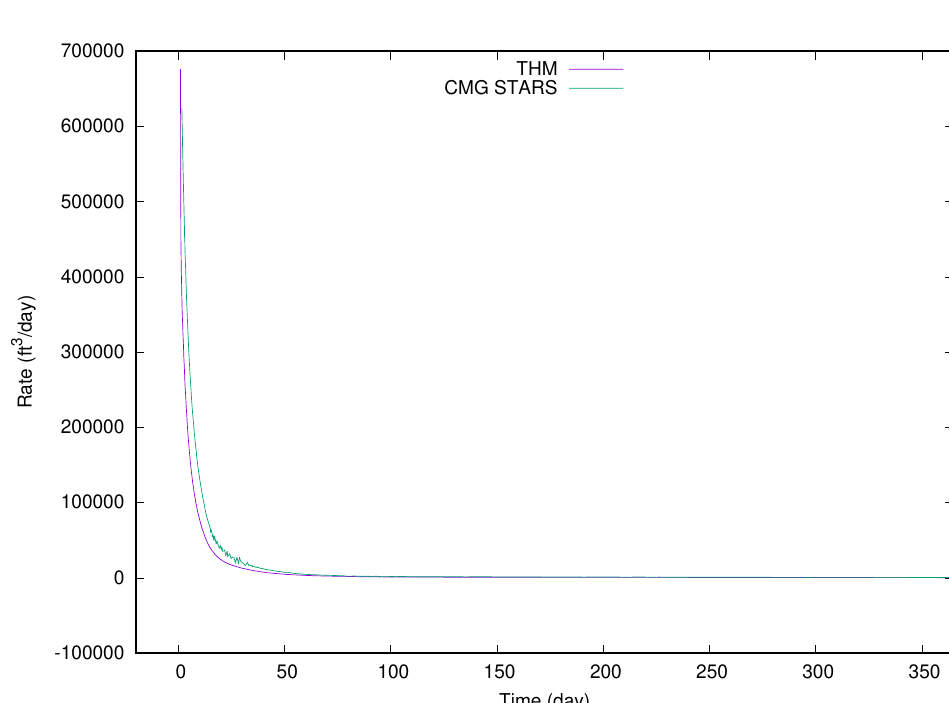
Figure 13. Example 2: total oil production rate (bbl/day).